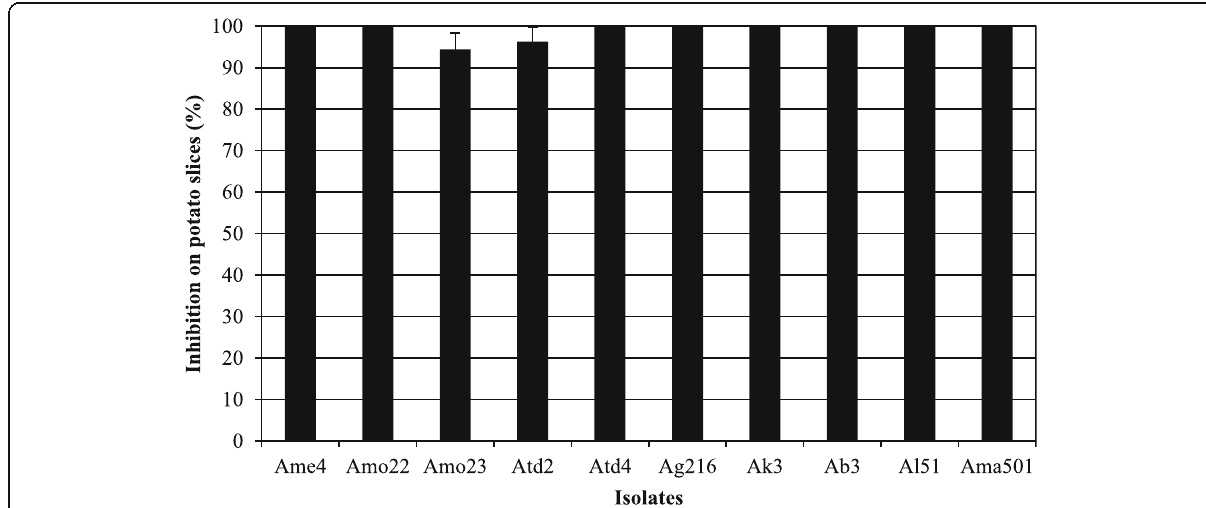
Fig. 4 Biocontrol activity of antagonist bacteria against soft rot caused by Pectobacterium carotovorum B1158 T on potato tuber slices. Suppression (%) = ((weight (g) of tissue soft rotted for the positive control – weight (g) of the tissue rotted)/ weight (g) of tissue soft rotted for the positive control) ×